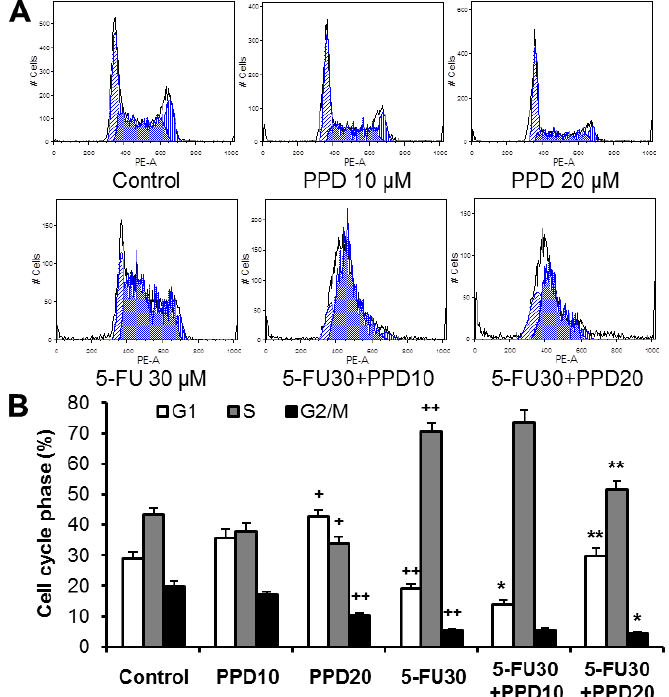
Figure 3. Effects of protopanaxadiol (PPD) on 5-FU-induced cell cycle arrest. HCT-116 human colorectal cancer cells were treated with PPD at various concentrations (10 and 20 µM) in the absence or presence of 5-FU (30 µM) for 48 h. The cell cycle was assessed using PI/RNase staining and flow cytometric analysis. ( A ) The representative histograms of DNA content in each experimental group; ( B ) percentage of each cell cycle phase with various treatments or with control. Data obtained from triplicate experiments. + p < 0.05; ++ p < 0.01 compared to control; * p < 0.05; ** p < 0.01 compared to 5-FU